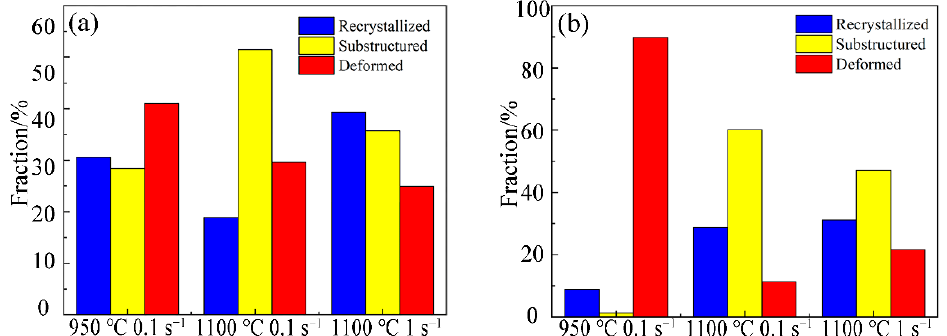
Figure 6. Volume fraction of recrystallized grains in ( a ) Q235 carbon steel and ( b ) 304 stainless steel.